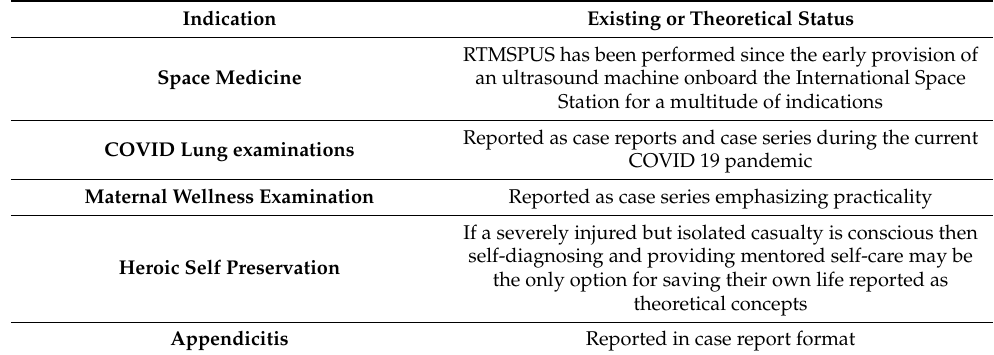
Table 1. Indications for Remote TeleMentored Self-Performed Ultrasound